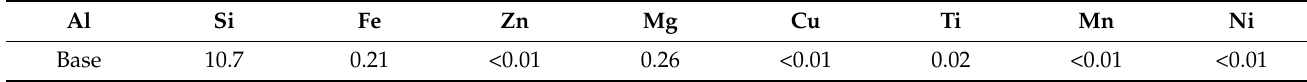
Table 1. Alloy chemical composition.